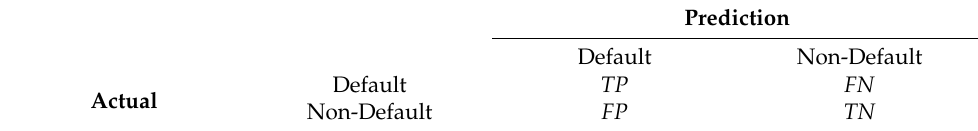
Table A1. Confusion Matrix.